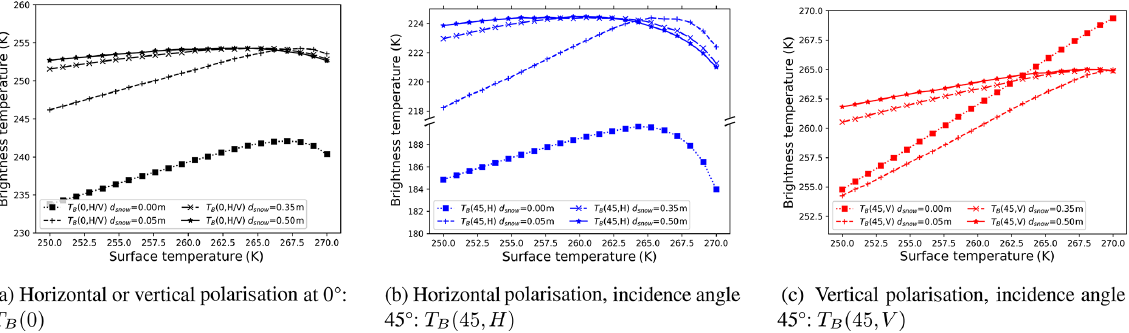
Figure 8. Change in the brightness temperature as predicted by the MILLAS emission model as a function of surface temperature. The different line styles correspond to the different snow thickness assumptions. The calculation was carried out for the sea ice thickness of 1m and surface roughness set to zero.